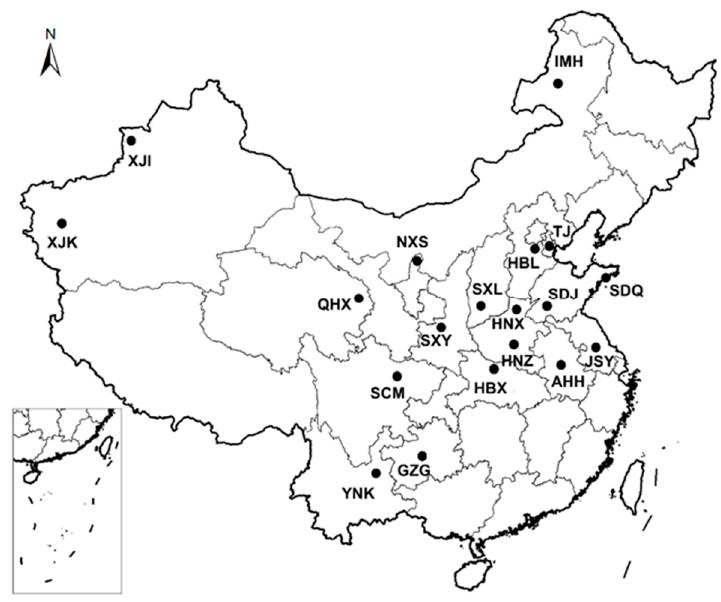
Figure 1. Wheat aphid sampling regions in China. The sampling regions included Xining, Qinghai (QHX); Shizuishan, Ningxia Hui Autonomous Region (NXS); Hailar, Inner Mongolia Autonomous Region (IMH); Yangling, Shanxi (SXY); Linfen, Shanxi (SXL); Xiangyang, Hubei (HBX); Yangzhou, Jiangsu (JSY); Hefei, Anhui (AHH); Xinxiang, Henan (HNX); Zhumadian, Henan (HNZ); Qingdao, Shandong (SDQ); Jining, Shandong (SDJ); Kashgar Prefecture, Xinjiang Uygur Autonomous Region (XJK); Ili Kazak Autonomous Prefecture, Xinjiang Uygur Autonomous Region (XJI); Langfang, Hebei (HBL); Tianjin (TJ); Mianyang, Sichuan (SCM); Kunming, Yunnan (YNK); and Guiyang, Guizhou (GZG).